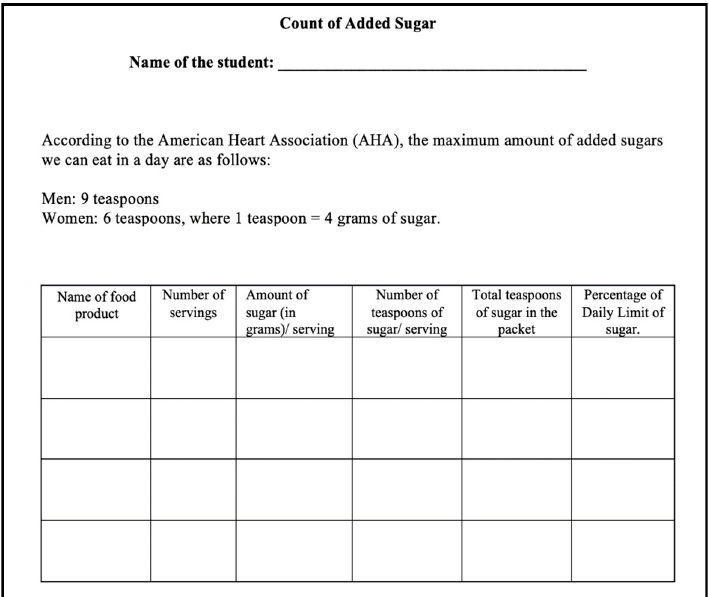
Figure 2. Worksheet: Count of Added Sugar.